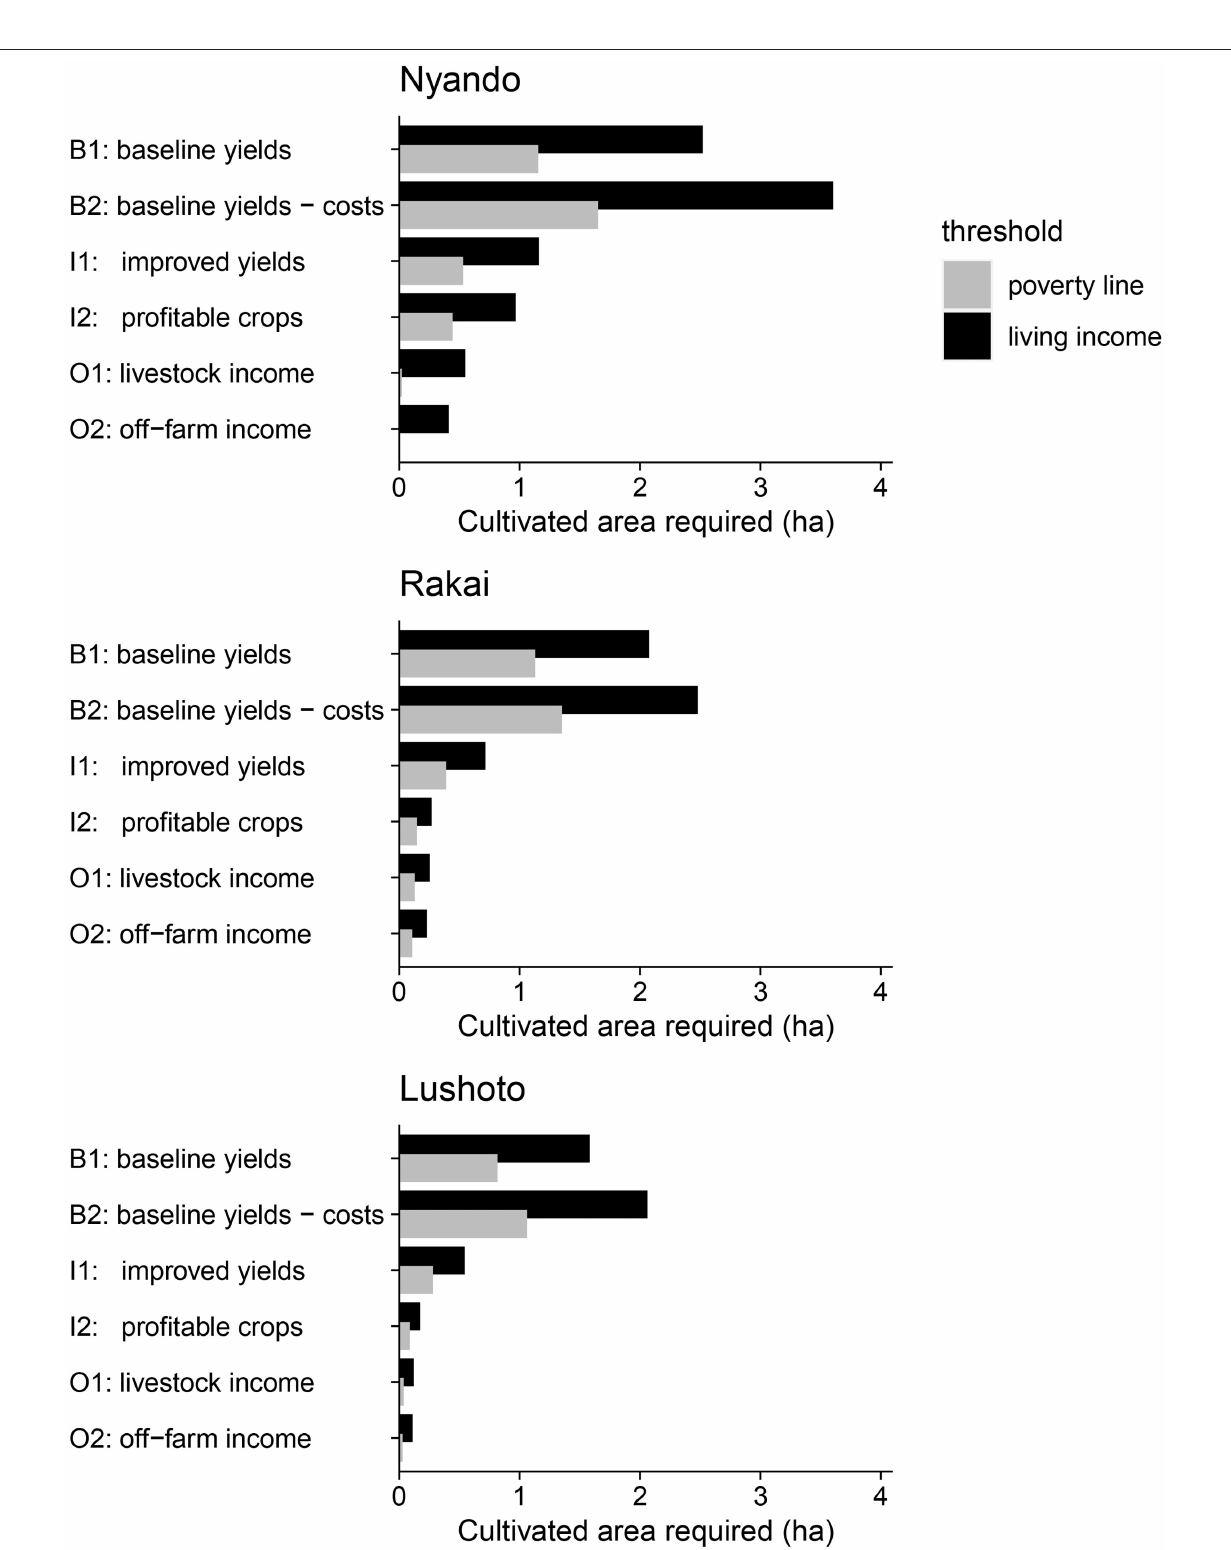
Frontiers in Sustainable Food Systems |